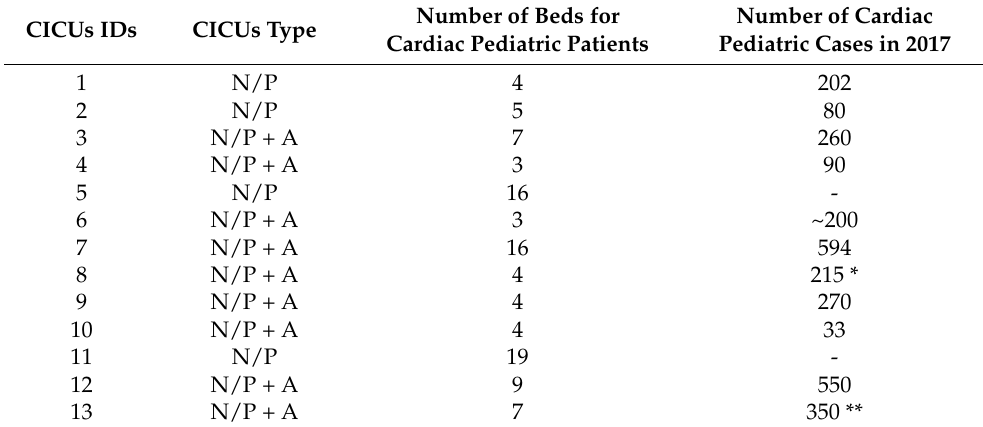
Table 1. Characteristics of the studied pediatric cardiac intensive care units (CICUs).